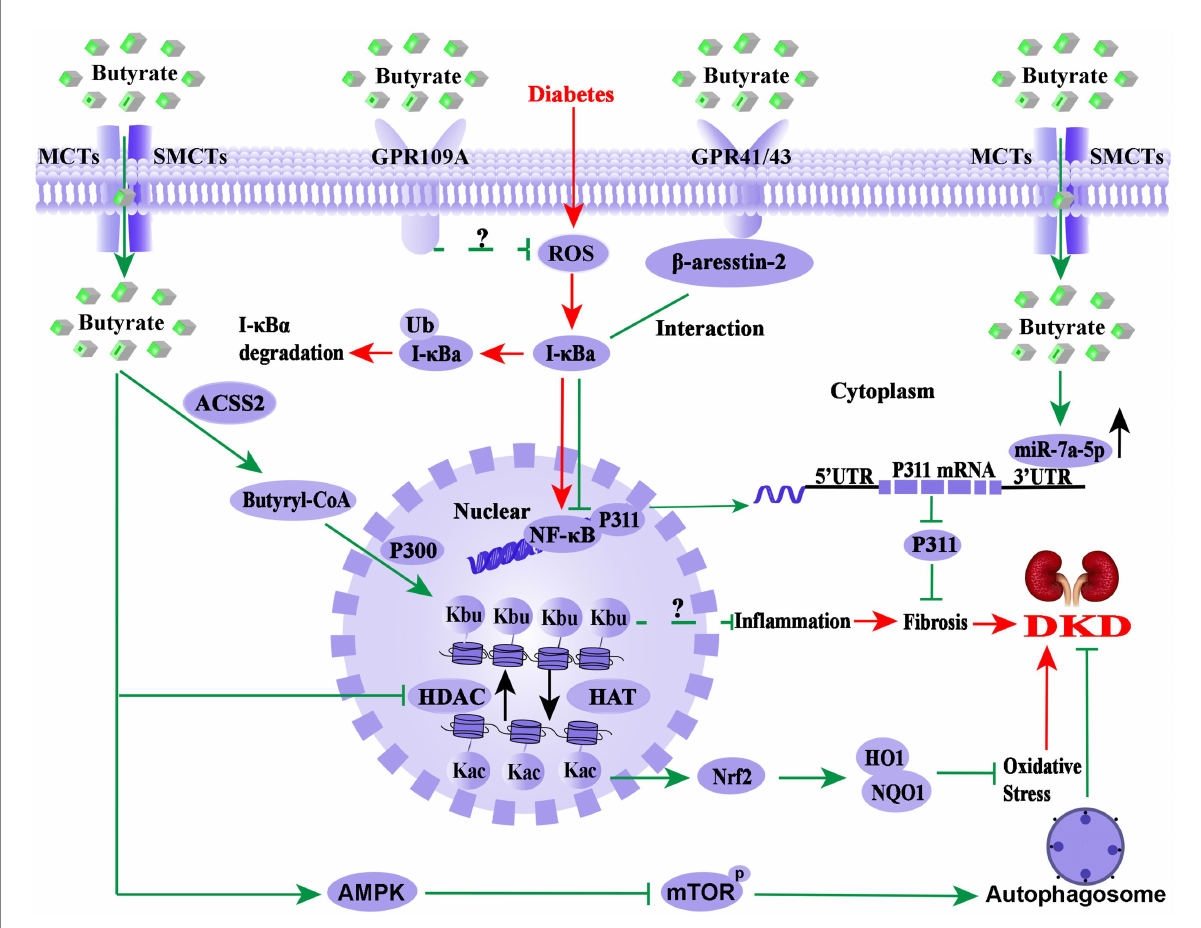
FIGURE 2 Overview of the molecular mechanism of butyrate in the prevention and treatment of DKD. The pathological process of DKD involves persistent HG-induced oxidative stress, immune system disorders, and inflammation (red arrows). Endogenous or exogenous butyrate (green arrows) inhibits the activity of HDAC, opens the structure of chromatin, and facilitates the expression of the Nrf2 gene, which may enter the nucleus and upregulate the downstream targets HO1 and NQO1 and then inhibits oxidative stress and inflammation in DKD. Meanwhile, GPR43 and GPR109A are important receptors of butyrate for renal protection, and the interaction between β -arrestin-2 and I- κ B α is induced by butyrate via GPR43, suggesting that butyrate-mediated GPR43- β -arrestin-2 signaling may be a novel and promising target for DKD (green arrows). Moreover, it has been found that butyrate reverses HG-induced the downregulation of miR-7a-5p and inhibits the expression of P311, followed by the inhabitation of the kidney fibrosis of DKD (green arrows) and activated autophagy via the AMPK/mTOR pathway to delay the DKD progression. Notably, butyl- CoA, a metabolite of butyrate, is the substrate of histone butyrylation modification, irrespective of whether butyrate or sodium butyrate improves DKD renal injury through histone butyrylation pathway or the cross-talk of the histone post-translational modifications has not been reported. Nrf2, Nuclear factor erythroid 2-related factor 2; HO1, heme oxygenase 1; NQO1, NAD(P)H dehydrogenase quinone 1; HDAC, histone deacetylase; HAT, histone acetyltransferase; UTR, untranslated region; NF- κ B, nuclear factor kappa B; Kbu, histone lysine butyrylation; Kac, histone lysine acetylation; ACSS2, acetyl-CoA synthetase 2; p300, a histone acetylation transferase that mediates butyrylation; P311, an RNA-binding protein, which could stimulate fibrosis; AMPK, AMP-activated protein kinase; mTOR, mammalian target of